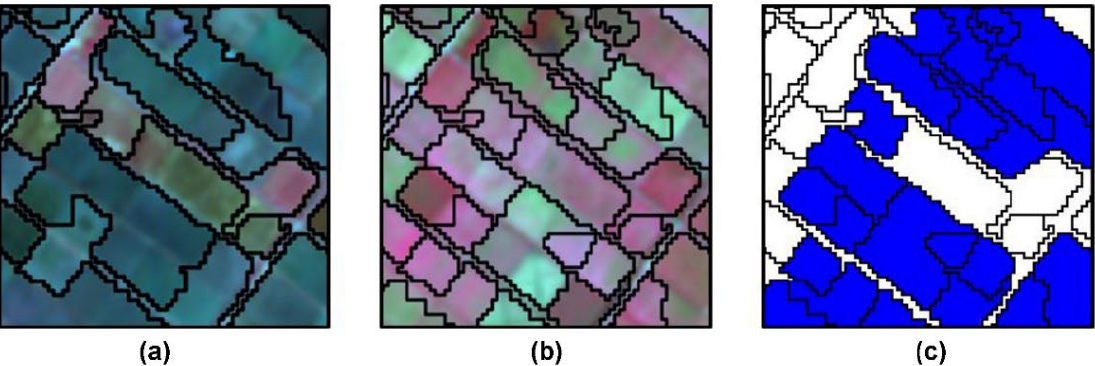
Figure 4. Illustration of multi-temporal segmentation results in the sub-area of Site 2. All color composite images are displayed with NIR-red-green as RGB: ( a ) Object boundaries superimposed on Sentinel-2 imagery at the base date (2 June 2018); ( b ) object boundaries superimposed on Sentinel-2 imagery at the prediction date (10 October 2018); and ( c ) changed objects highlighted in blue, where black polygons denote the objects boundaries in both ( a , b ). Table 2. Band-wise accuracy statistics of interim prediction results of HIFOW on the two study sites. The best case is shown in